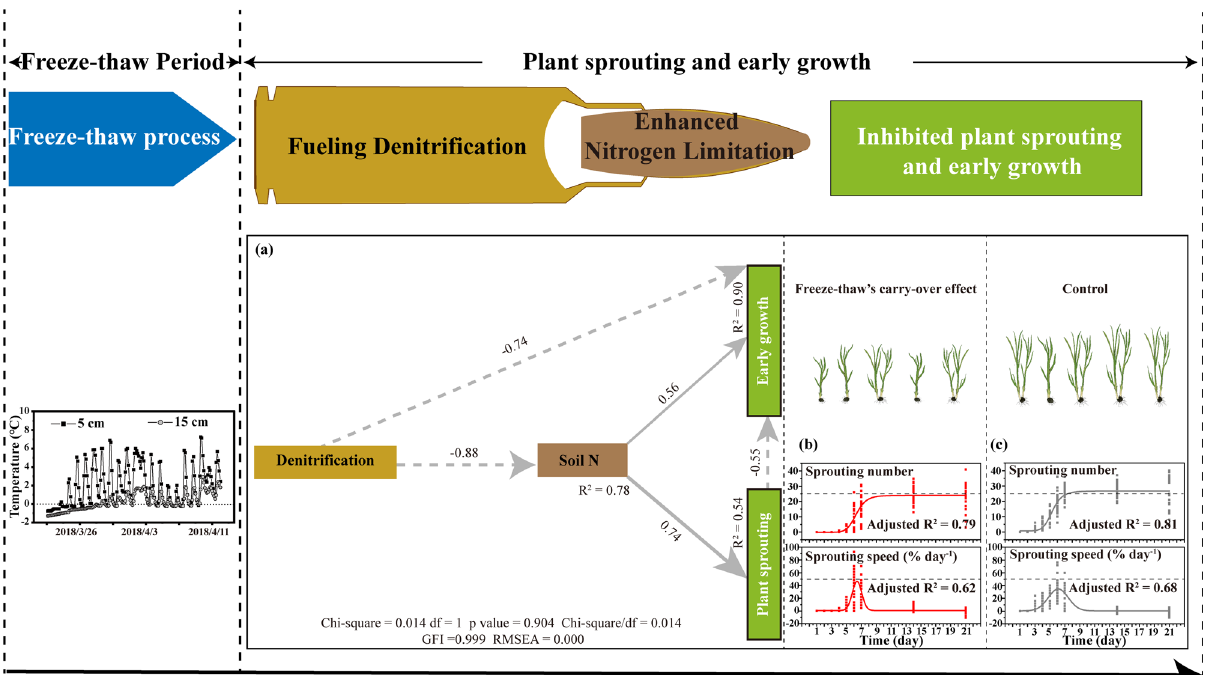
Fig. 5 Conceptual representation of the cascade relationship of soil microbes, soil nutrients, and plant sprouting and early growth under the freeze- thaw ’ s carry-over effects. a The result of the SEM (dashed and solid lines represent negative and positive relationships, respectively; R 2 represents the explained variation; the values on the lines indicate standardized path coef fi cients; paths with signi fi cant coef fi cients ( p < 0.05) are shown); b , c the sprouting- time